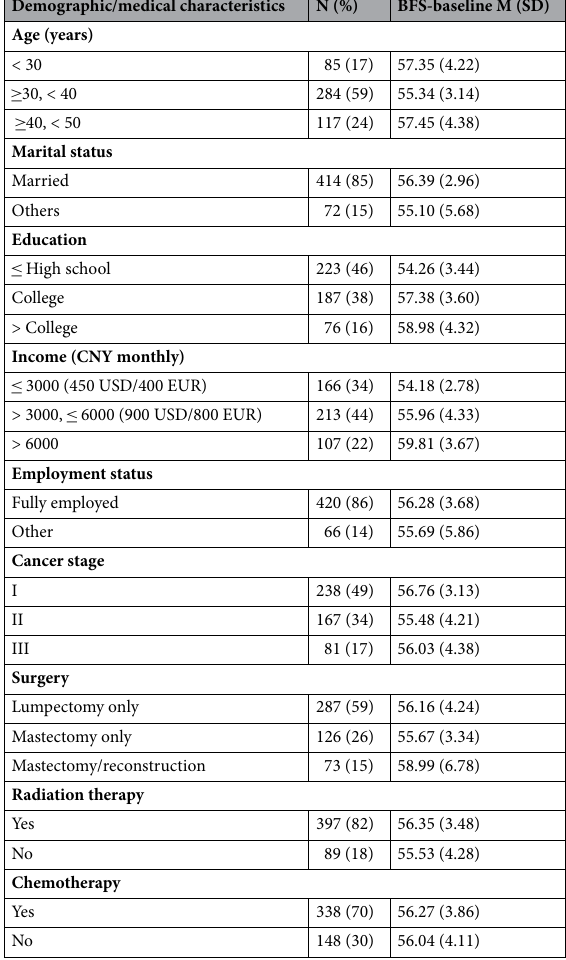
Table 1. Characteristics of the study sample (N = 486) and BF scoring at